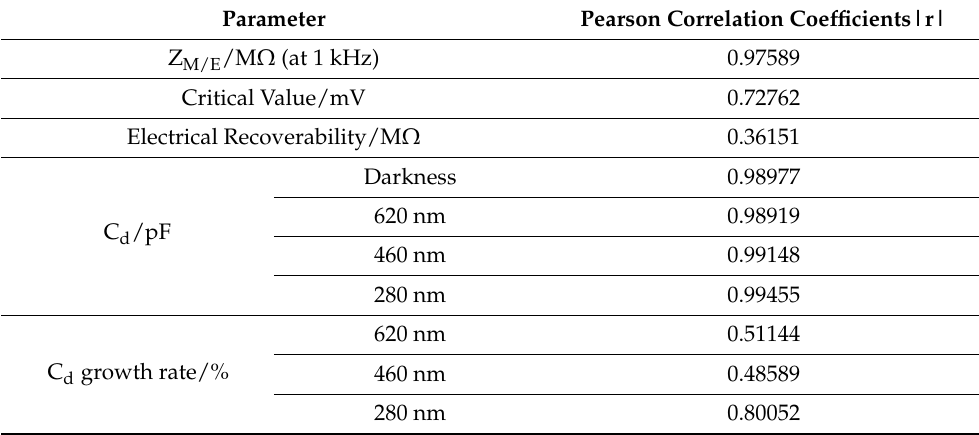
Table 3. Pearson correlation coefficients (|r|) of the recorded optical artifacts and other parameters.